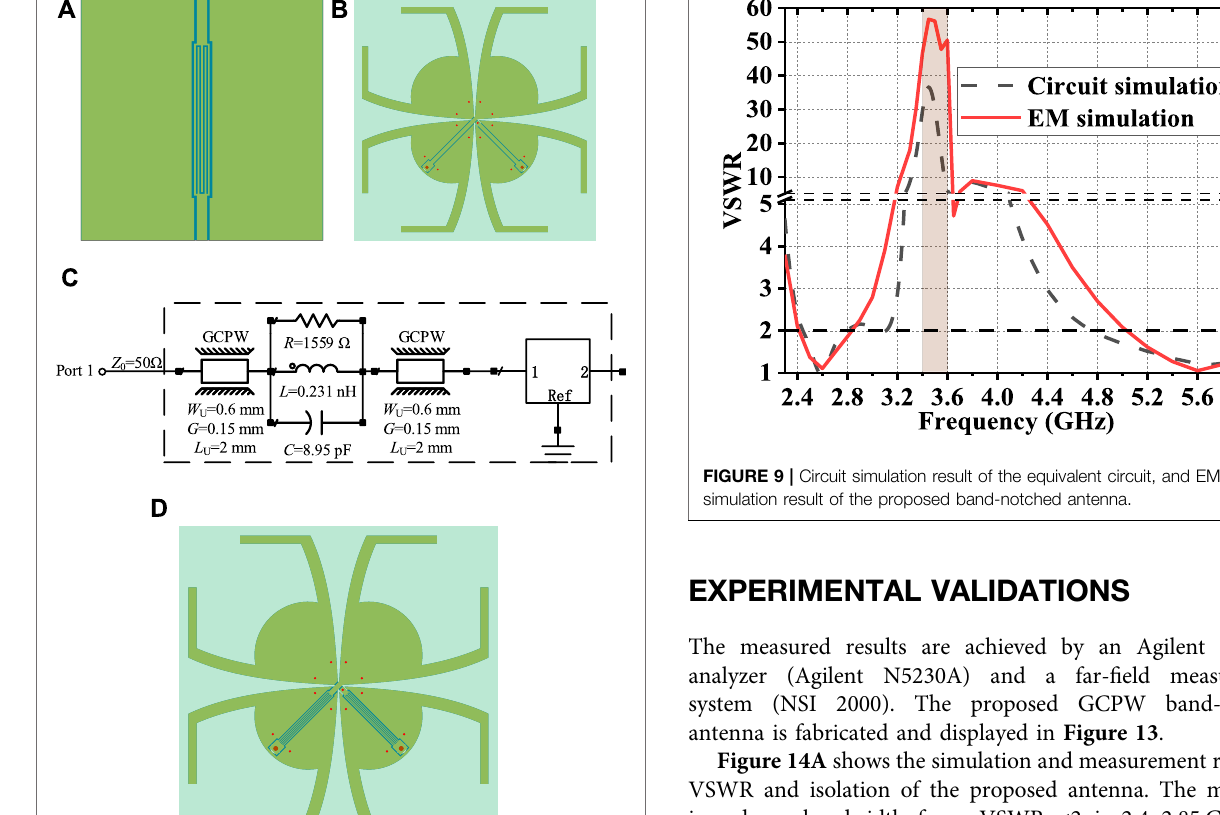
Frontiers in Physics |